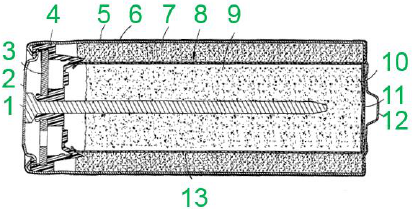
Figure 10. Schematic of a cylindrical cell design from Eveready/Freudenberg. The parts are 1: negative current collector, 2: negative terminal, 3: metal plate, 4: polymer seal, 5: metalized plastic film, 6: steel can, 7: tubular positive electrode, 8: separator, 9: negative electrode, 10: bottom of negative electrode, 11: bottom of folding cylinder, 12: positive terminal, and 13: folding can [118].